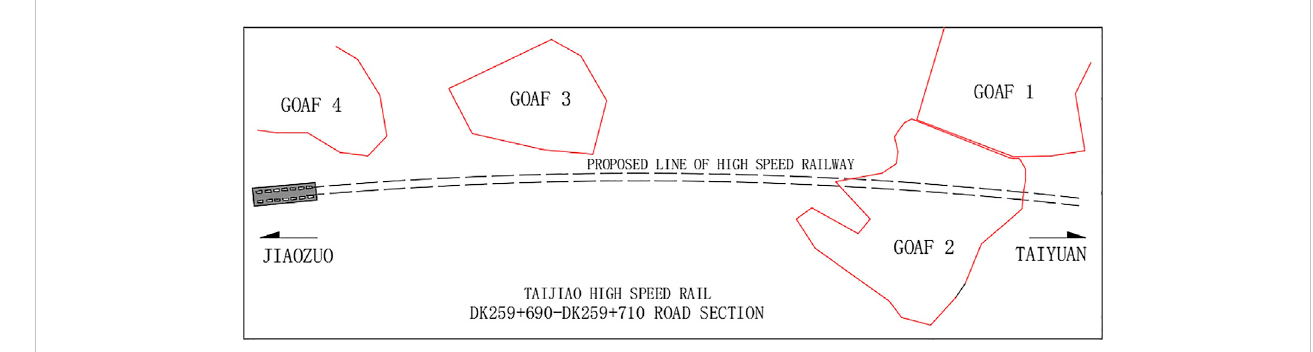
FIGURE 8 Distribution of goafs.